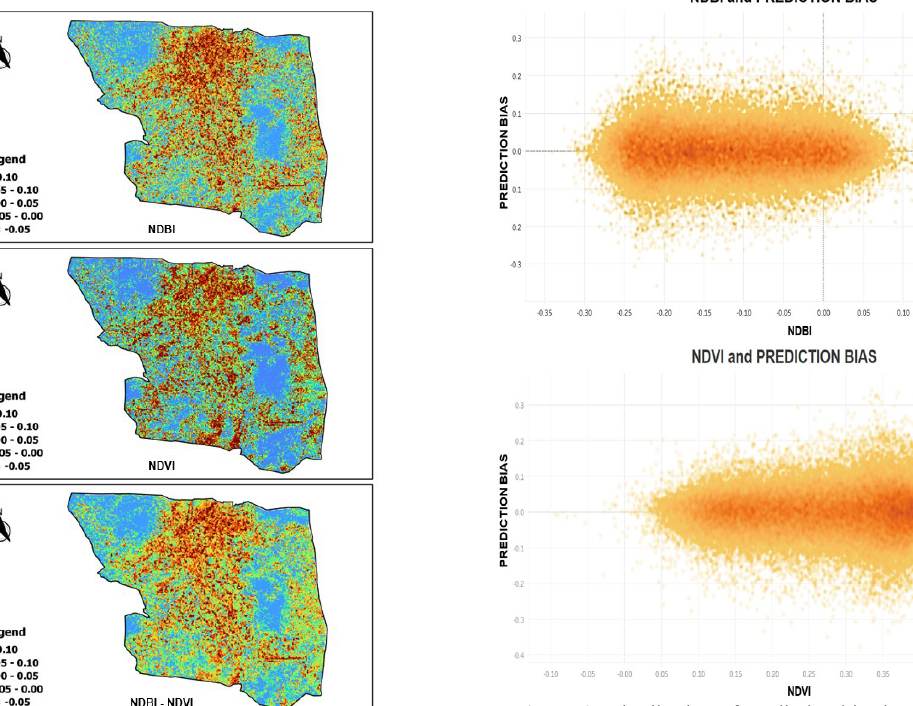
Figure 9. Distribution of prediction bias in relation to NDBI and NDVI observed values. The scatter plots revealed that vegetation areas are more likely to have overprediction and underprediction of